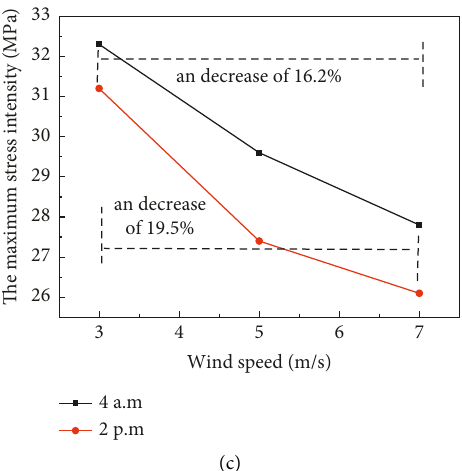
Figure 17: The maximum stress strength intensity of the concrete: (a) influence of solar radiation absorption coefficient, (b) influence of daily ambient temperature difference, and (c) influence of wind speed.